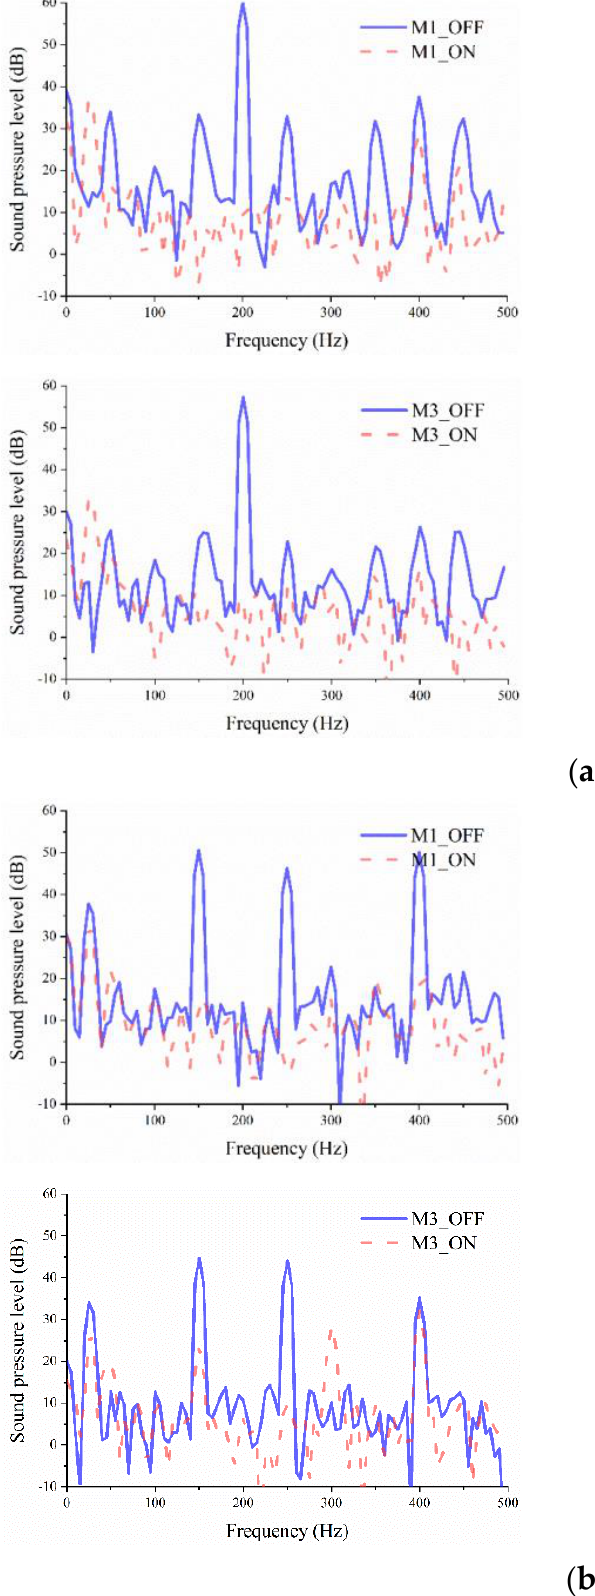
Figure 11. Noise spectrum of the target area before and after 4 ‐ channel fractional ‐ order active noise control: ( a ) 200 Hz single ‐ frequency; ( b ) 150 Hz, 250 Hz, and 400 Hz mixed ‐ frequency.